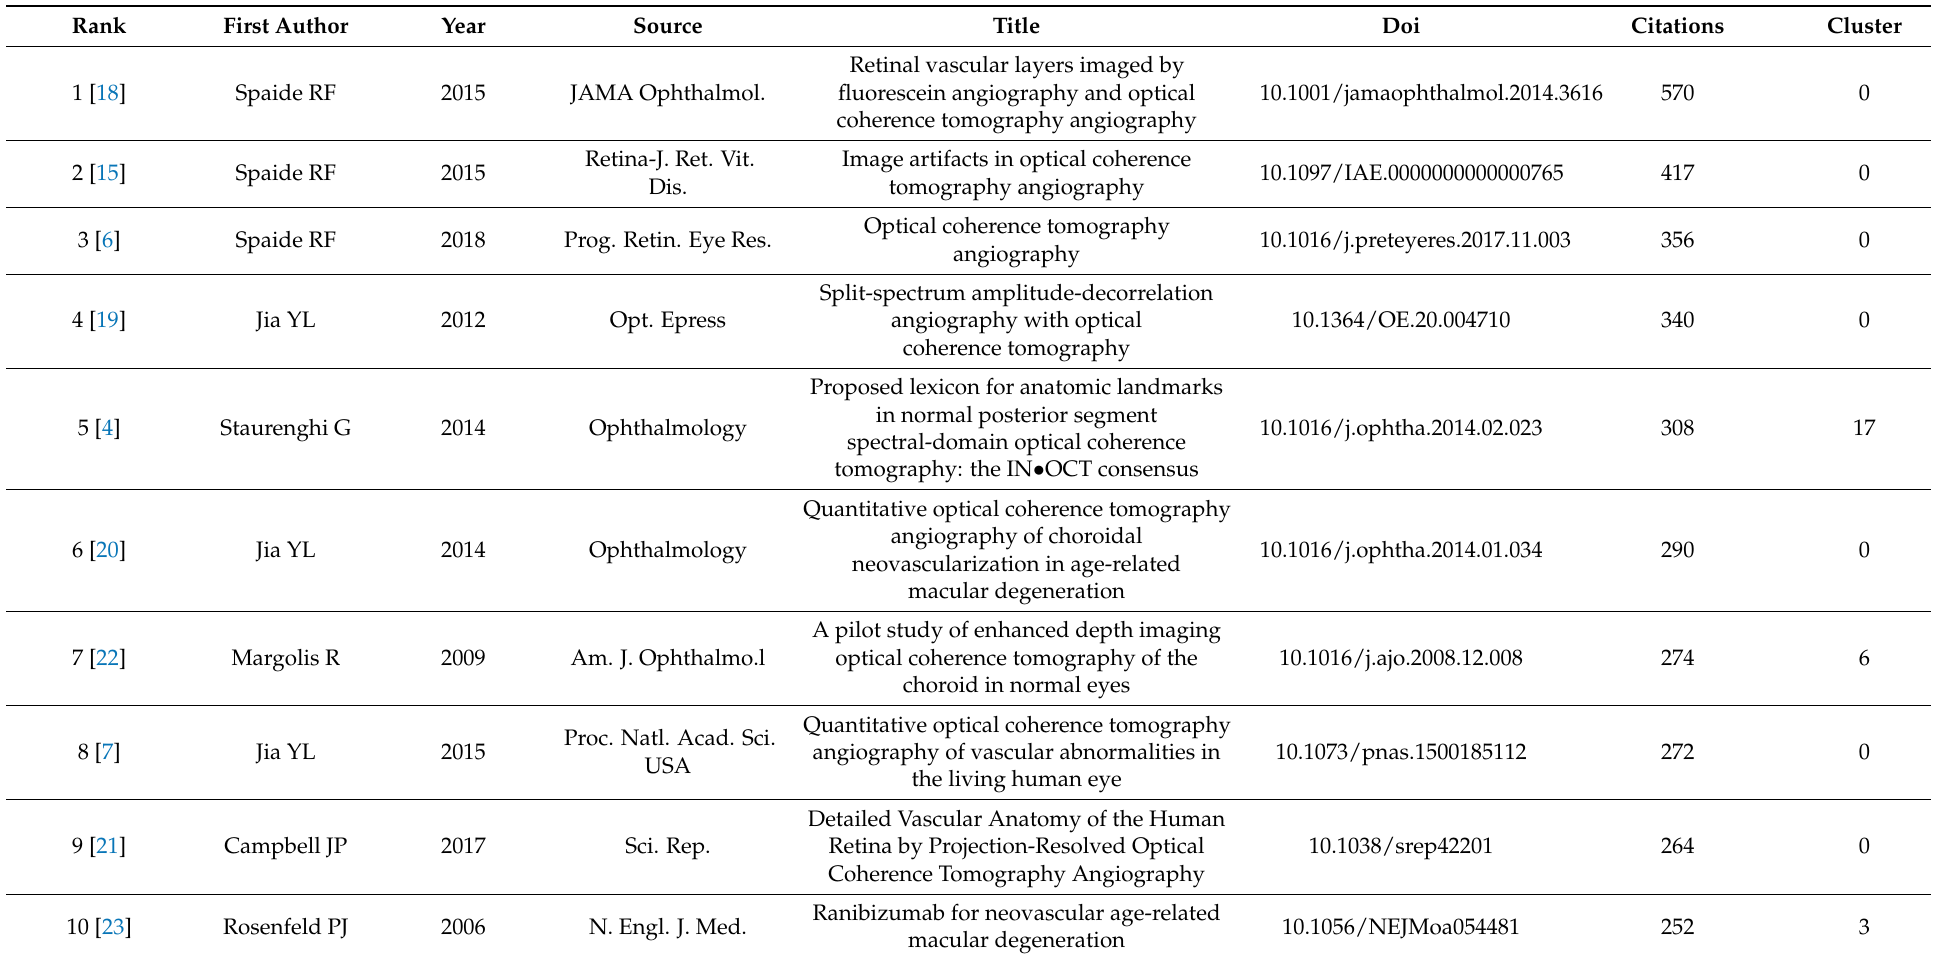
Table 1. The top 10 most co-cited